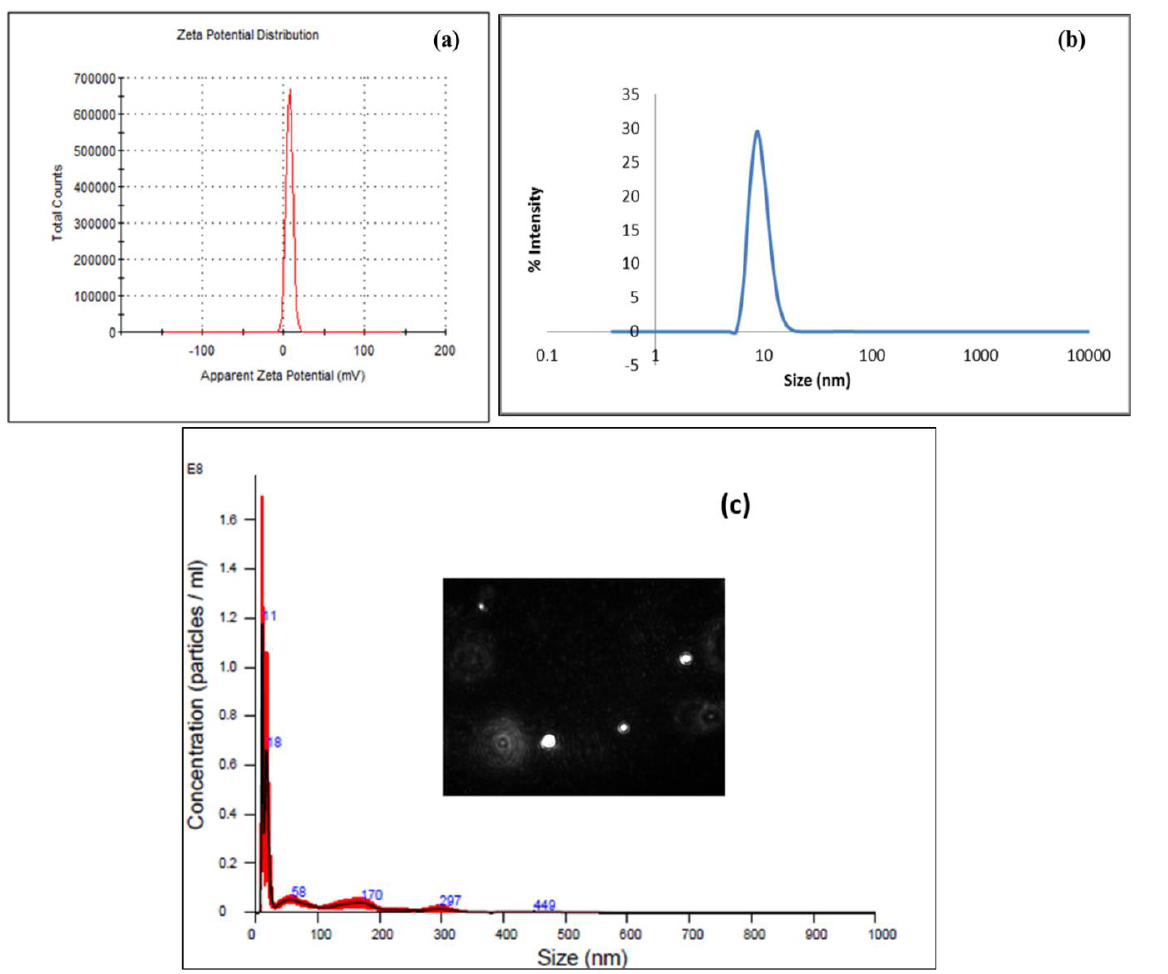
Figure 4. ( a ) Zeta potential of AgNPs by DLS, ( b ) Histogram showing the calculated particle size of AgNPs by DLS ( c ) Nanoparticle tracking analysis showing the Brownian motion of AgNPs, and that most of the particles are < 30 nm.